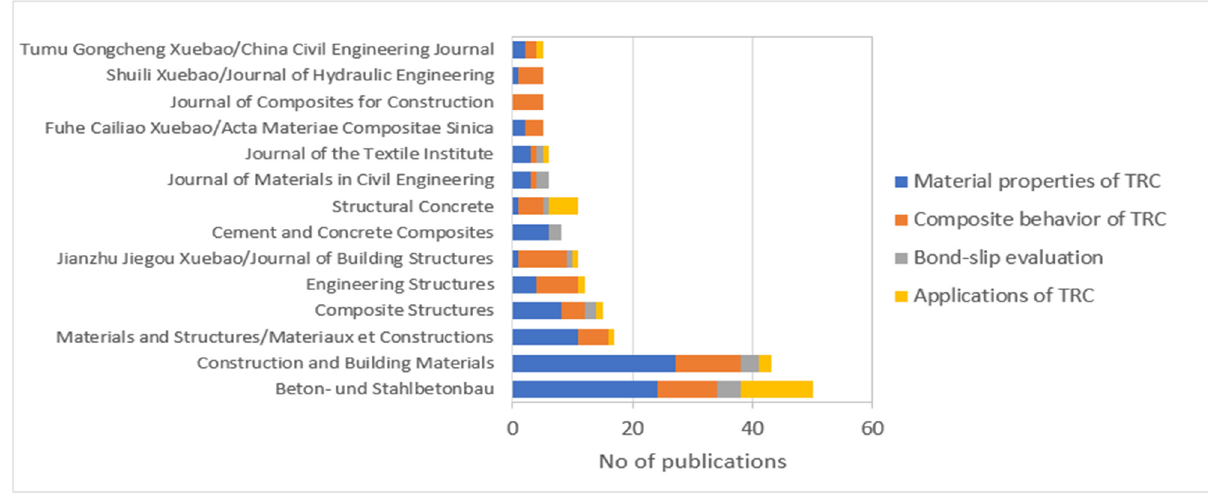
Figure 4. Main journals in TRC.